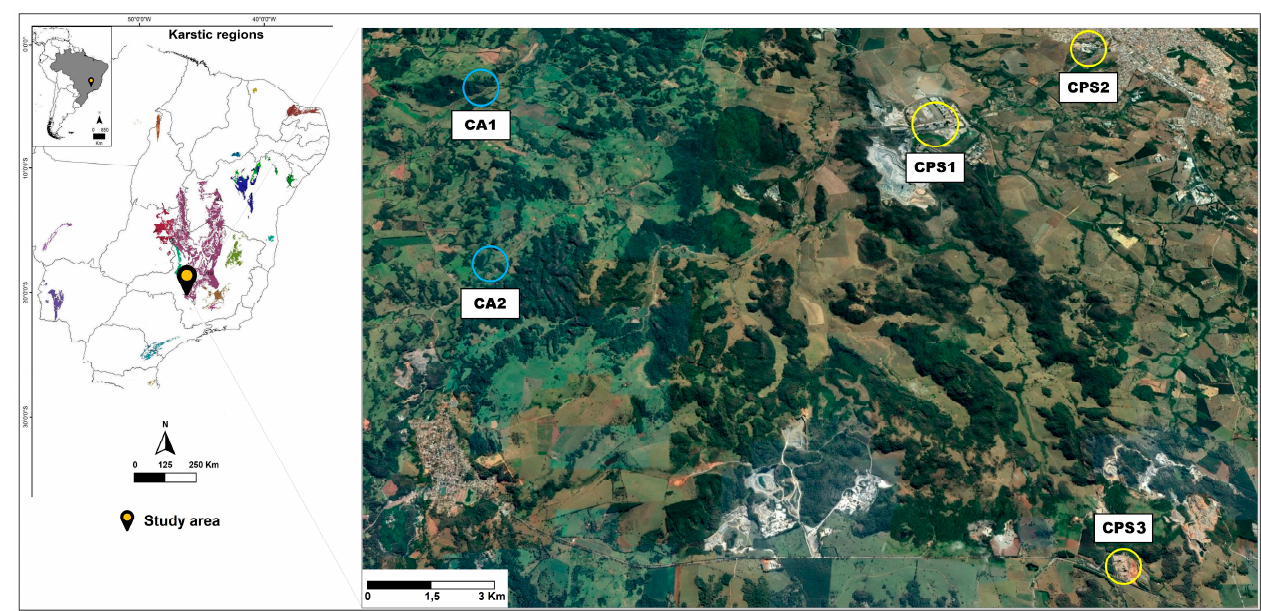
Figure 1. On the right, Google Map of study area comprising the location of control (blue circles) and cement plant surroundings (yellow circles) sampling sites. On the left, map of the karst regions of Brazil, highlighting the location of the study area in the southeast region of Brazil.